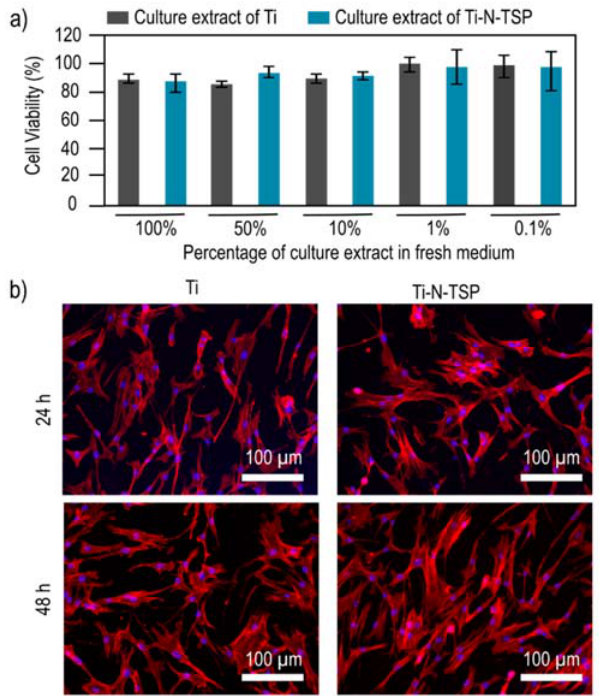
Figure 4. ( a ) Cell viability of Human Foreskin Fibroblasts (HFFs) cells onto titanium surfaces after 1 day of incubation at different culture extract concentrations. ( b ) Confocal laser scanning microscopy (CLSM) images of HFFs cells adhesion at 24 and 48 h. Phalloidin − rhodamine (red signal) was used to stain the actin filaments of the cells. The blue fluorescence signal arises from 4 ′ ,6 ‐ diamidino ‐ 2 ‐ phenylindole (DAPI), nucleus staining.